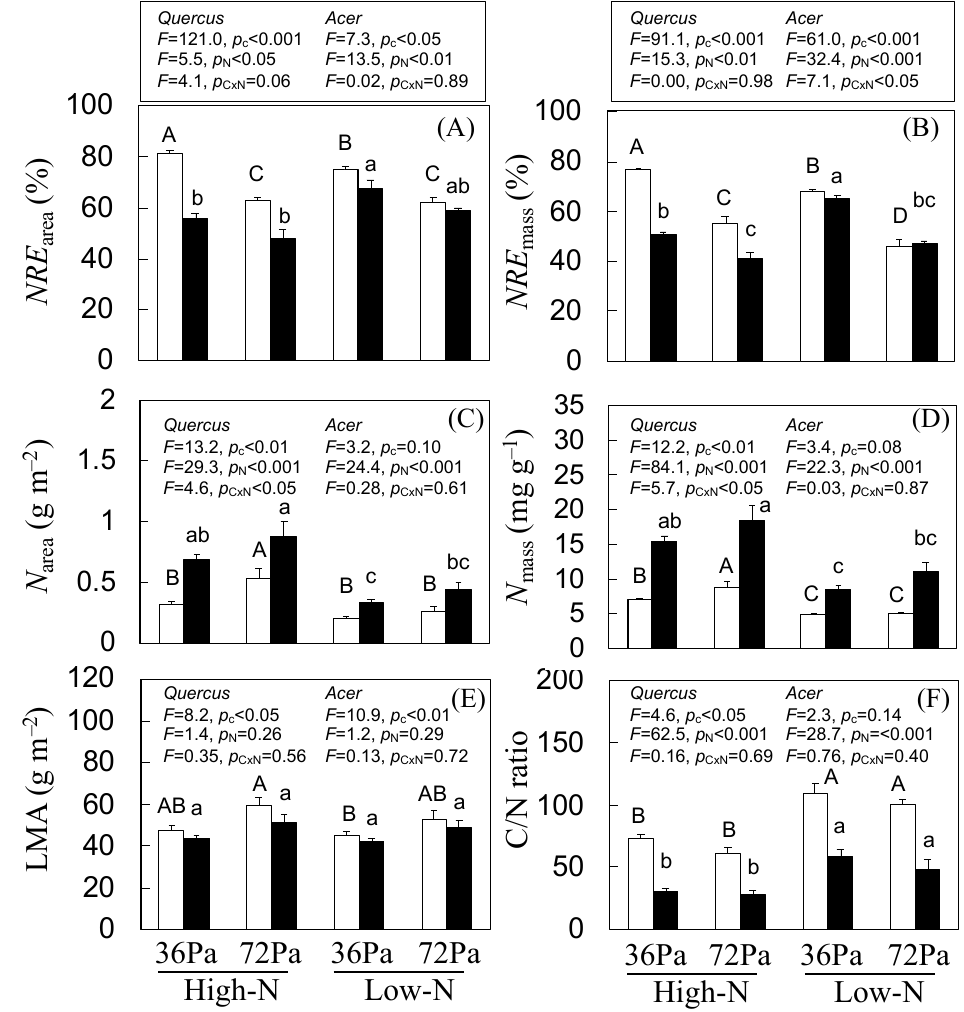
Figure 3. Area-based N resorption efficiency (NRE) ( NRE area ; ( A )) and mass-based NRE ( NRE mass ; ( B )) during defoliation as well as area-based N content ( N area ; ( C )), mass-based N content ( N mass ; ( D )), leaf mass per area (LMA; ( E )), and C/N ratio ( F ) of fallen leaves of Quercus mongolica and Acer mono . Means and standard errors are shown ( n = 6). Open bars: Q. mongolica ; closed bars: A. mono ; ambient CO 2 : 36 Pa; elevated CO 2 : 72 Pa. F -value and probability ( P ) of the effects of CO 2 ( p C ), N ( p N ), and their interaction ( p CxN ) for Q. mongolica ( Quercus ) and A. mono ( Acer ) are indicated in or above the panel. Uppercase and lowercase letters represent multiple comparison results among four treatments when the treatment effects are significant at p < 0.05 for Q. mongolica and A. mono , respectively.